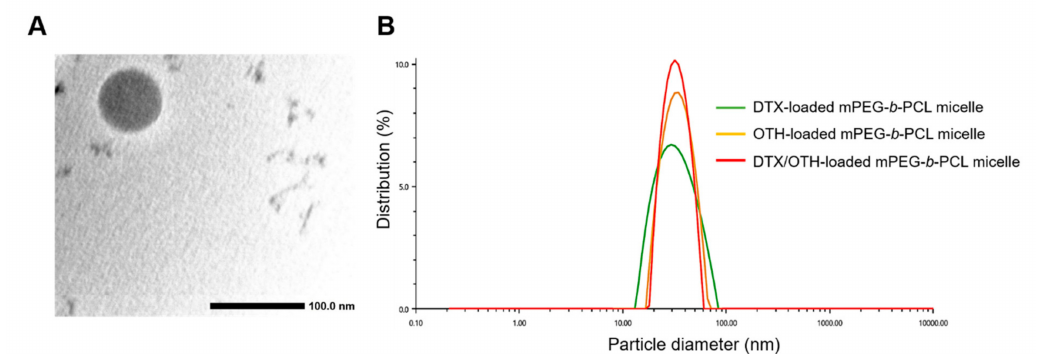
Figure 1. Transmission electron microscopy (TEM) image of docetaxel (DTX) and osthol (OTH)-loaded mPEG- b -PCL micelles ( A ). Representative size distribution analysis of DTX-loaded mPEG- b -PCL micelles, OTH-loaded mPEG- b -PCL micelles, and DTX/OTH-loaded mPEG- b -PCL micelles ( B